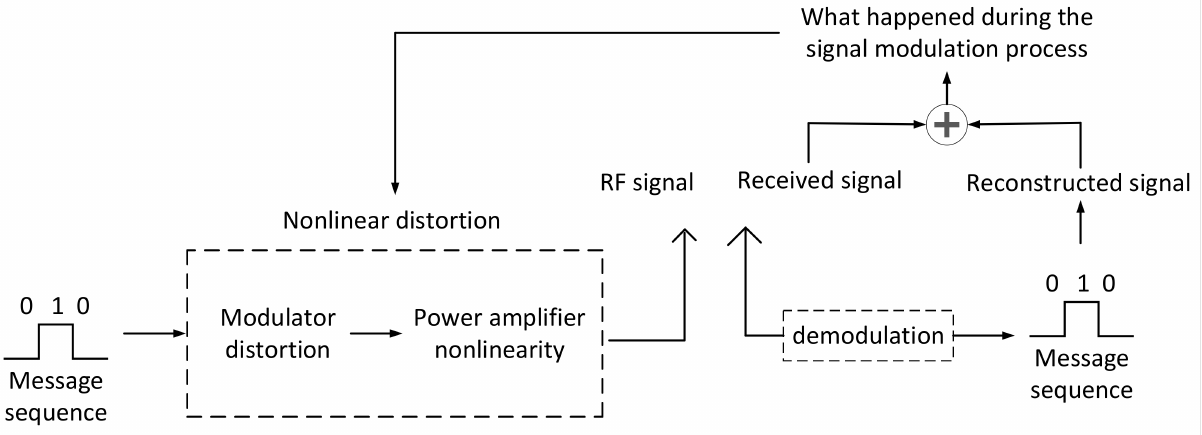
Figure 1. Feature-extraction